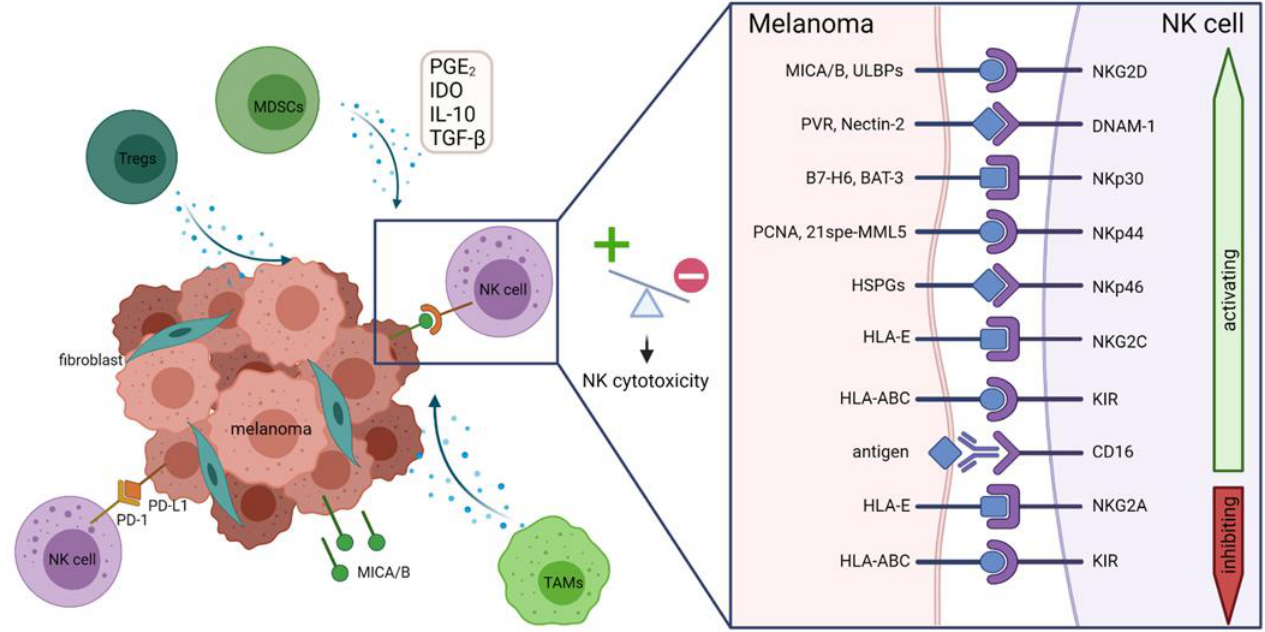
Figure 1. The TME shapes the activity of NK cells in melanoma. Different immunosuppressive immune cells such as Tregs, MDSCs and TAMs have a direct effect on the activity of NK cells by releasing factors such as PGE 2 , IDO, IL-10 and TGF- β . Even fibroblasts and the melanoma cells can release inhibiting factors. These factors can down or upregulate specific NK cell receptors or cause shedding of ligands, such as MICA/B on the melanoma site, leading to a shifted balance of signaling from activating to inhibiting status. This can result in NK cell deficiency. Ligand immune checkpoint expression on melanoma such as PD-L1 also influences NK cell activity.